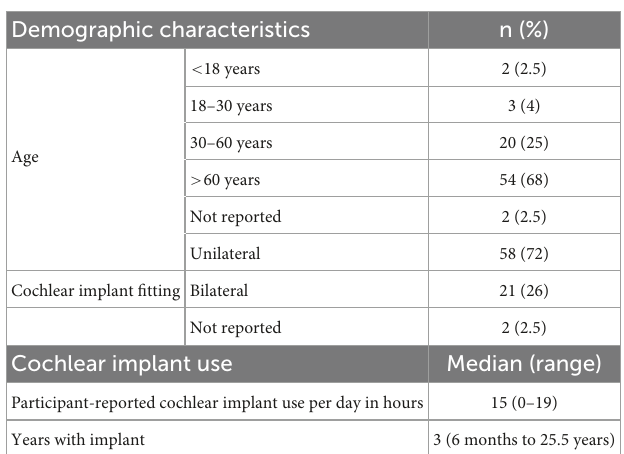
TABLE 1 Participant characteristics ( N = 81).